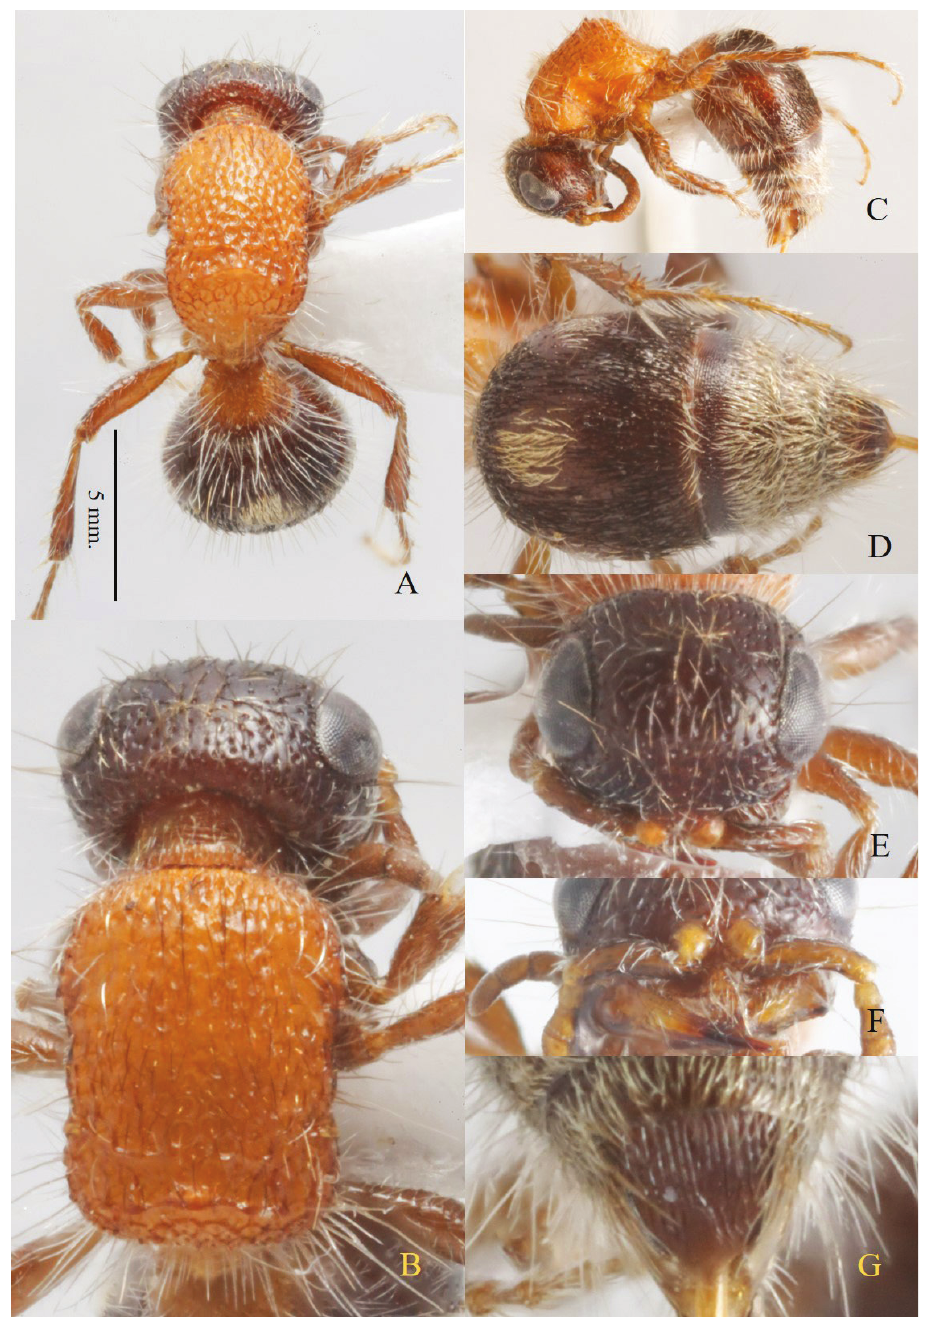
Figure 3. Mickelomyrme leleji sp.nov., holotype, female A dorsal view B mesosoma dorsum C lateral view D metasomal terga E vertex F clypeus G